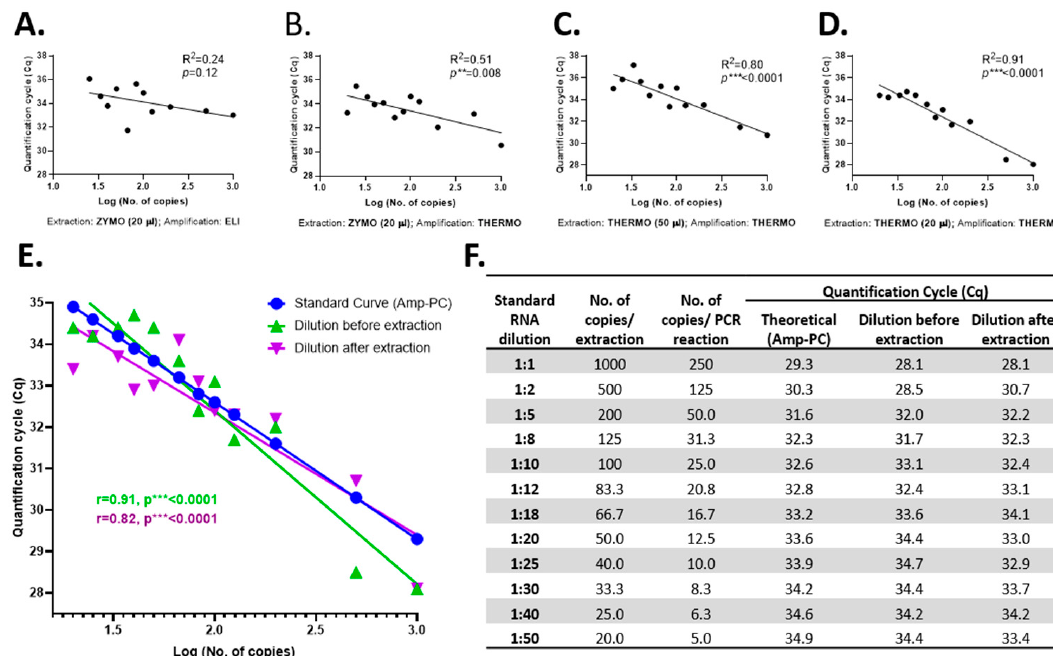
Figure 4. The RT-qPCR limit of detection of SARS-CoV-2 RNA processed with the most efficient combination of extraction and amplification kits: the correlation between the number of RNA copies (serial dilutions) and the quantification cycle (Cq) at which they were detected, for SARS-CoV-2 Reference Material extracted with ZYMO and amplified with ELI ( A ) and THERMO ( B ), extracted with THERMO in a final elution volume of 50 µ L ( C ) and 20 µ L ( D ) and amplified with THERMO; the overlap between the theoretical standard curve of amplification calculated based on the Cq of the Amp-PC (amplification positive control—TaqMan 2019-nCoV Control Kit v2, #CCU001L, Applied BioSystems) and the regression lines obtained experimentally, based on the amplification of the serial dilutions of SARS-CoV-2 Reference Material, diluted either before or after the extraction step ( E ); the Cq values obtained for each dilution of SARS-CoV-2 Reference Material (before and after extraction) compared with the theoretical Cq calculated based on the amplification of the Amp-PC. For the data presented in ( E , F ), the extraction kit used was THERMO (elution volume: 20 µ L), and the amplification kit was THERMO. The statistical significance was assessed in terms of the goodness of fit ( R 2 ) of the linear regression ( p ** < 0.01, p *** < 0.001).